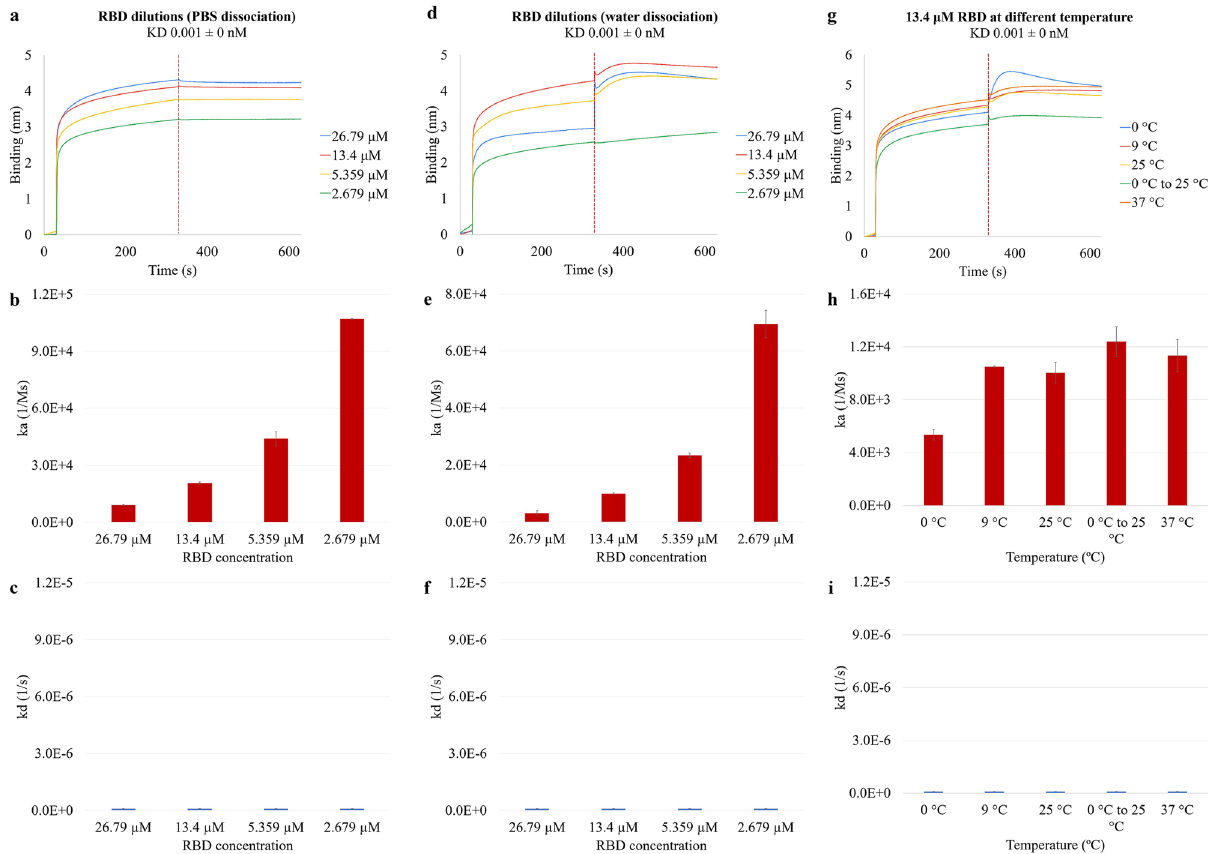
Figure 3. The effects of protein concentrations, ionic PBS dissociation, water dissociation, and temperature on the attachment and detachment of RBD to and from the hydrophobic APS sensors. The binding curves were generated from the basic kinetics analysis of 26.79 µM, 13.4 µM, 5.359 µM, and 2.679 µM RBD dissociating ( a ) in PBS and ( d ) in purified water, and ( g ) 13.4 µM RBD at 0 °C, 9 °C, 25 °C, 0 °C to 25 °C, and 37 °C dissociating in water. The vertical dotted line on the figures indicates the end of the association or the start of the dissociation step. The association constant ka was shown for the four S protein concentrations dissociating ( b ) in PBS and ( e ) in water, and ( h ) for 13.4 µM RBD at 0 °C, 9 °C, 25 °C, 0 °C to 25 °C, and 37 °C dissociating in water. The dissociation constant kd was shown in the same order for the three groups of conditions in ( c ), ( f ), and ( i Similar to the S protein, decreasing RBD concentrations show increasing rate of association (Fig. 3b), and the difference of the ka among the four concentrations was statistically significant (p = 0.0001). The kd values of 26.79 µM, 13.4 µM, 5.359 µM, and 2.679 µM were 1.00E−7 s −1 , 1.00E−7 s −1 , 1.00E−7 s −1 , and 1.00E−7 s −1 , respec-